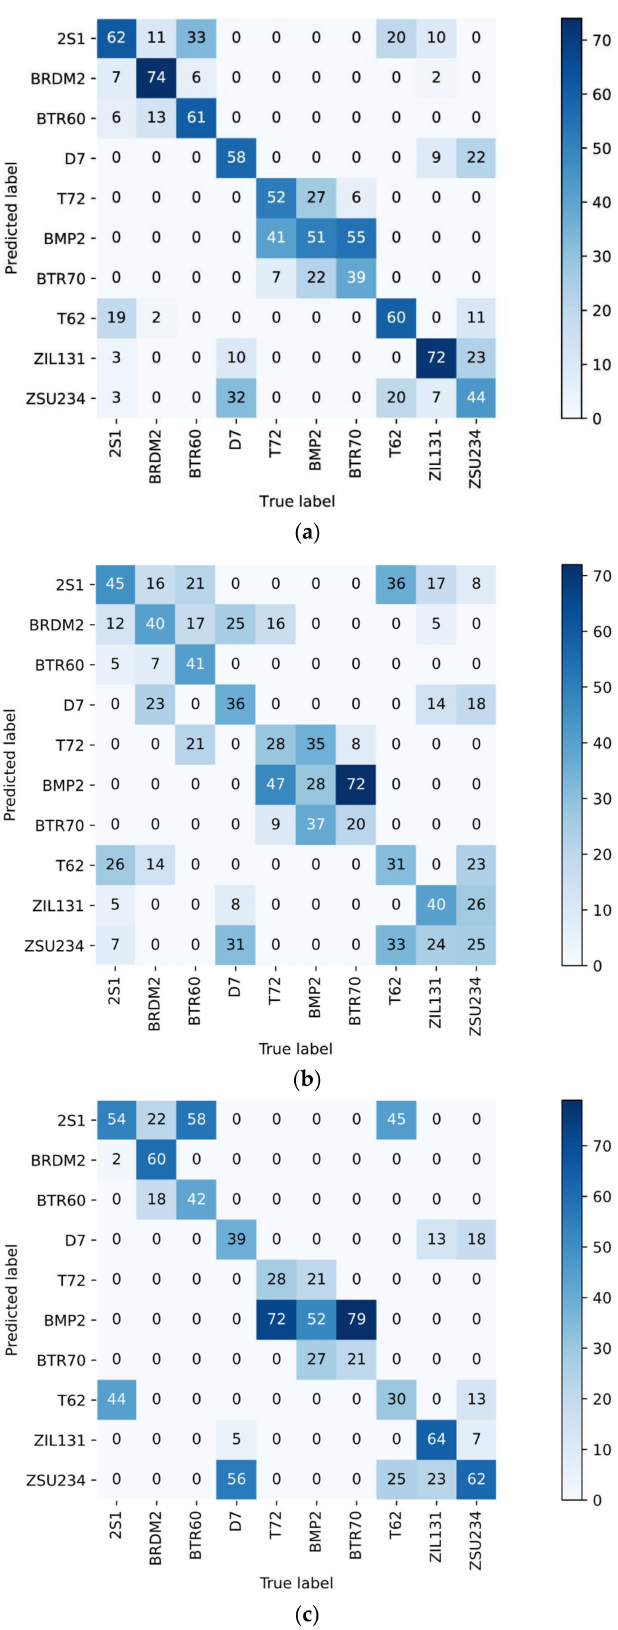
Figure 7. Frequencies heat map of ( a ) the proposed method, ( b ) Fea-DA, and ( c ) GAN_OSR. The same true label as the predicted label means that the class is recognized as